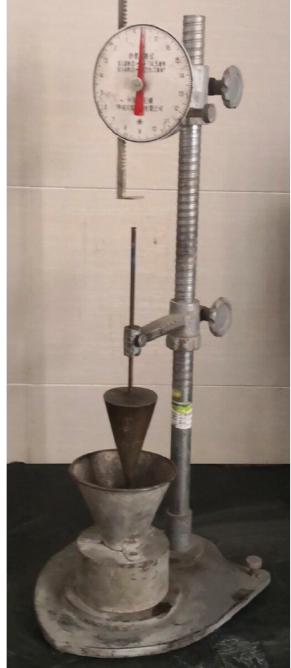
Figure 2: Mortar consistency